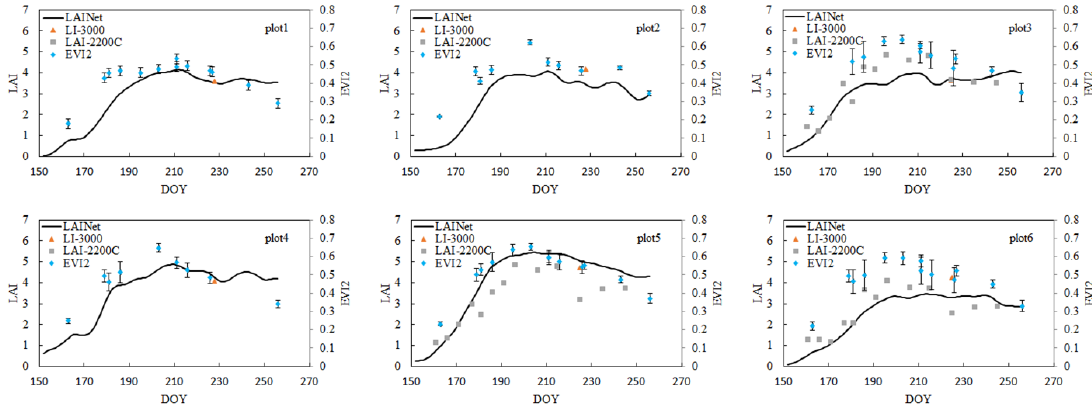
Figure 5. Temporal variation in field LAI measurements collected by LAINet, LAI-2200C, and LI-3000 at 6 corn plots in 2019. DOY stands for day of year.